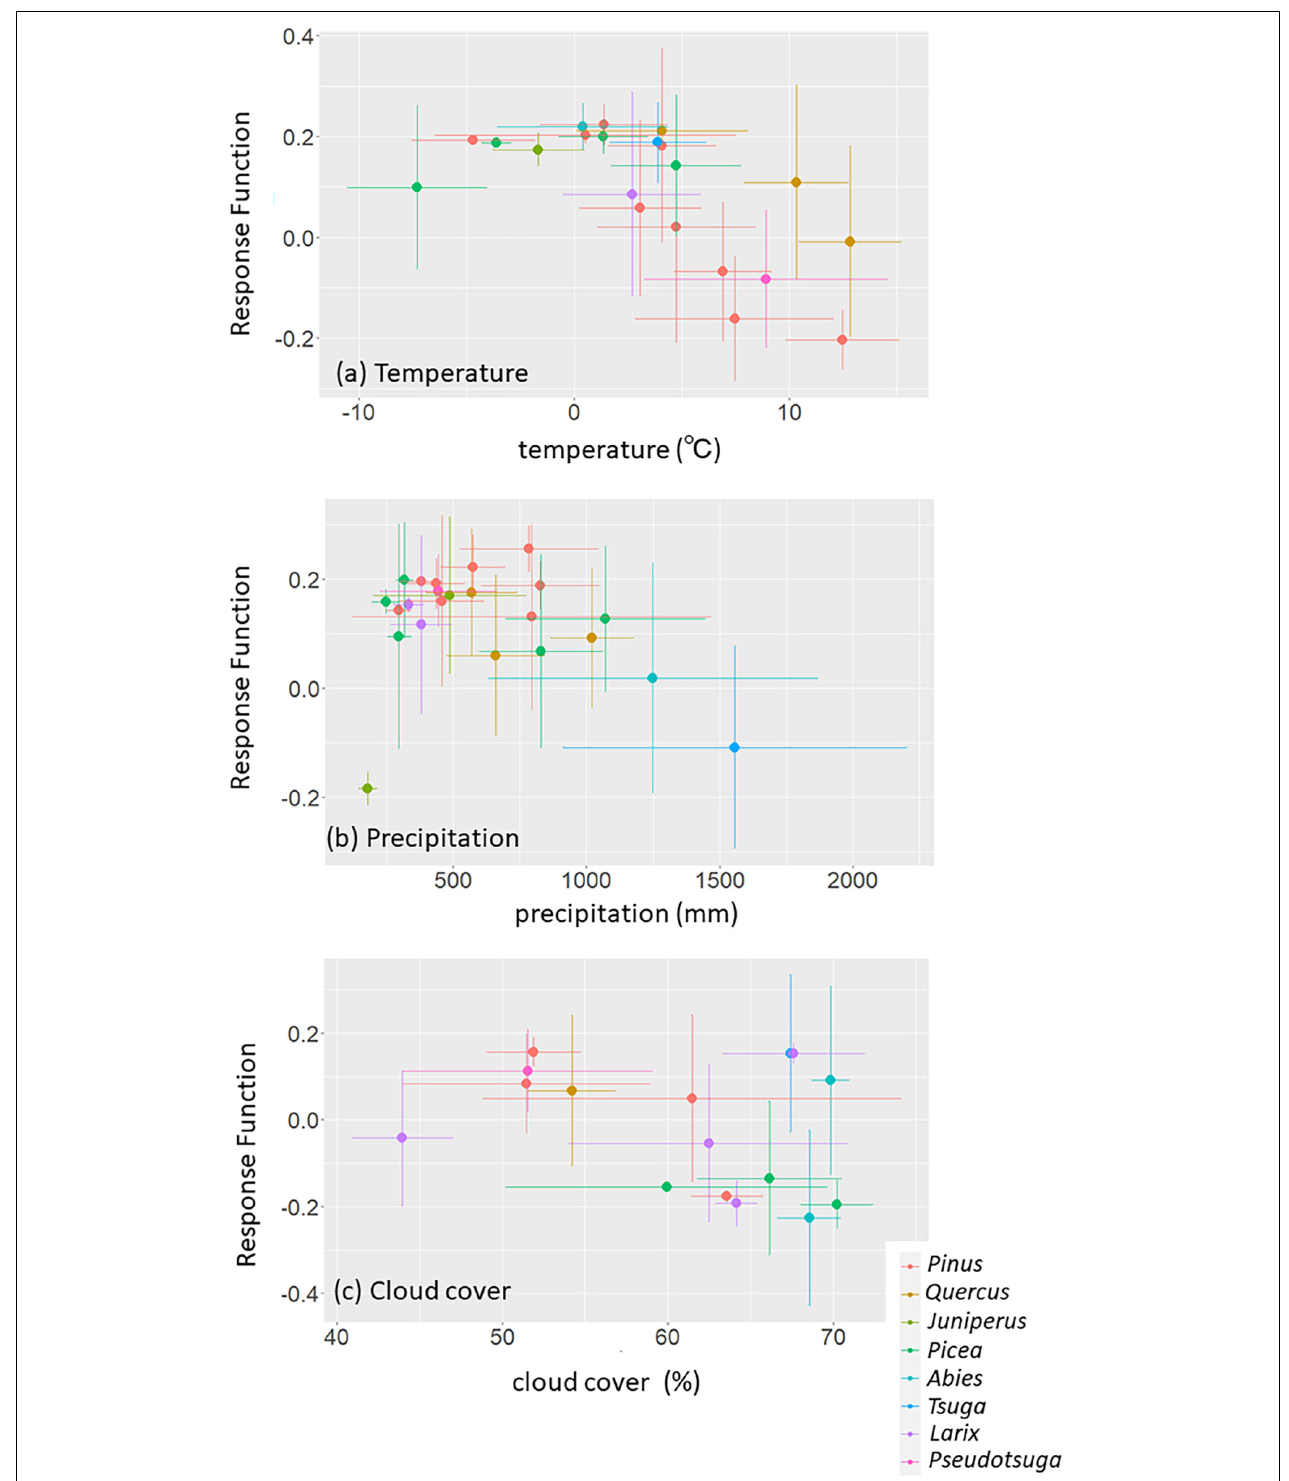
FIGURE 5 | Relationship between the climatic condition and the response function (RF) coefficients for (A) temperature, (B) precipitation, and (C) cloud cover, in autumn season. We used annual averaged temperature/cloud cover and annual cumulative precipitation. Both the site climatic condition and coefficient are averaged or cumulative by tree species. Colors indicate tree genera. To ensure a sufficient number of sites for each tree genera and species, we limited our analysis to RWI sites with tree genera observed at 90 or more sites and with tree species observed at 5 or more sites from those sites with significant RF coefficients for each autumn climate